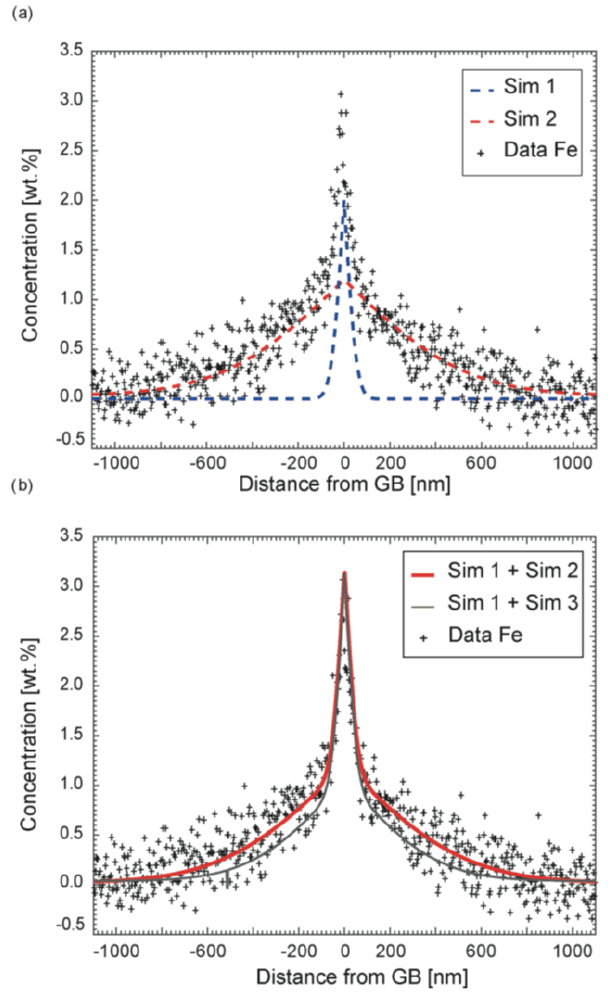
Figure 11. Experimental Fe diffusion profile (TH_9_2, 1005, 1000nm from the groove), which can be simulated only if two independent and different diffusion coefficients are assumed for iron. In all simulations shown, sD gb is fixed to 10 − 11 m 2 s − 1 , whereas D vol was varied. Sim 1: D vol = 10 − 20 m 2 s − 1 , Sim 2: D vol = 10 − 18 m 2 s − 1 , Sim 3: D vol = 6 × 10 − 19 m 2 s − 1 . The count- ing error is smaller than the symbol size. (a) A simulation with D vol = 10 − 20 m 2 s − 1 (Sim 1) reproduces the steep part of the ex- perimental profile close to the grain boundary. The flatter part of the concentration profile can be approximately fitted with D vol = 10 − 18 m 2 (Sim 2). (b) The sum of the two simulated profiles repro- duces the overall Fe profile (bold red line, Sim 1 + Sim 2). Keep- ing all other boundary conditions constant, the two diffusion coef- ficients are well constrained by the quality of the fit. Another simu- lated profile (thin black line, Sim 1 + Sim 3) is added to illustrate the sensitivity of the visual fitting procedure. The lower profile clearly does not reproduce the data as well as the upper profile (thick,